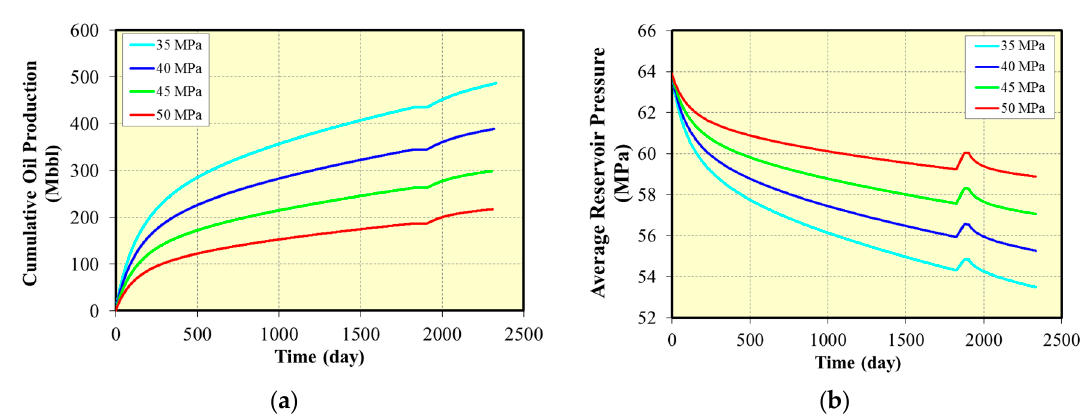
Figure 28. Effect of different BHP of primary depletion with one huff-n-puff cycle on oil production and reservoir pressure: ( a ) Cumulative oil production for different BHP of primary depletion; ( b ) Average reservoir pressure for different BHP of primary depletion.